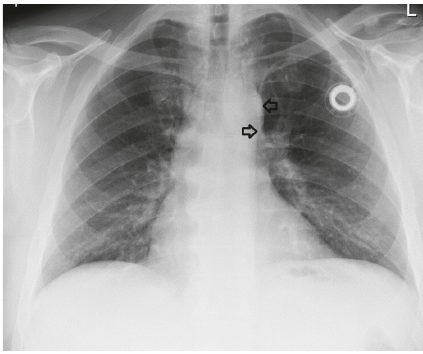
Figure 2: The a.p. chest X-ray shows the port catheter in the left- sided superior vena cava (black arrows).